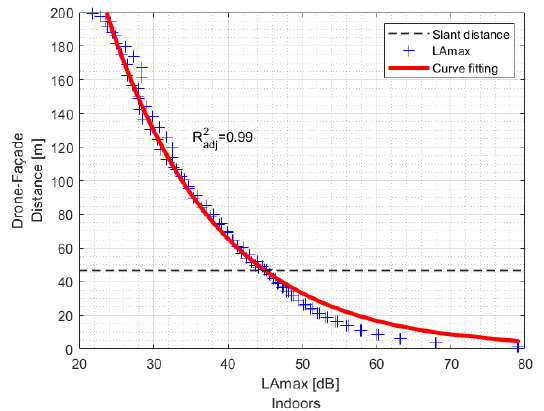
Figure 8. Drone/façade distance DFd as a parameter to estimate fitting curve model as a function of LA max , indoors .